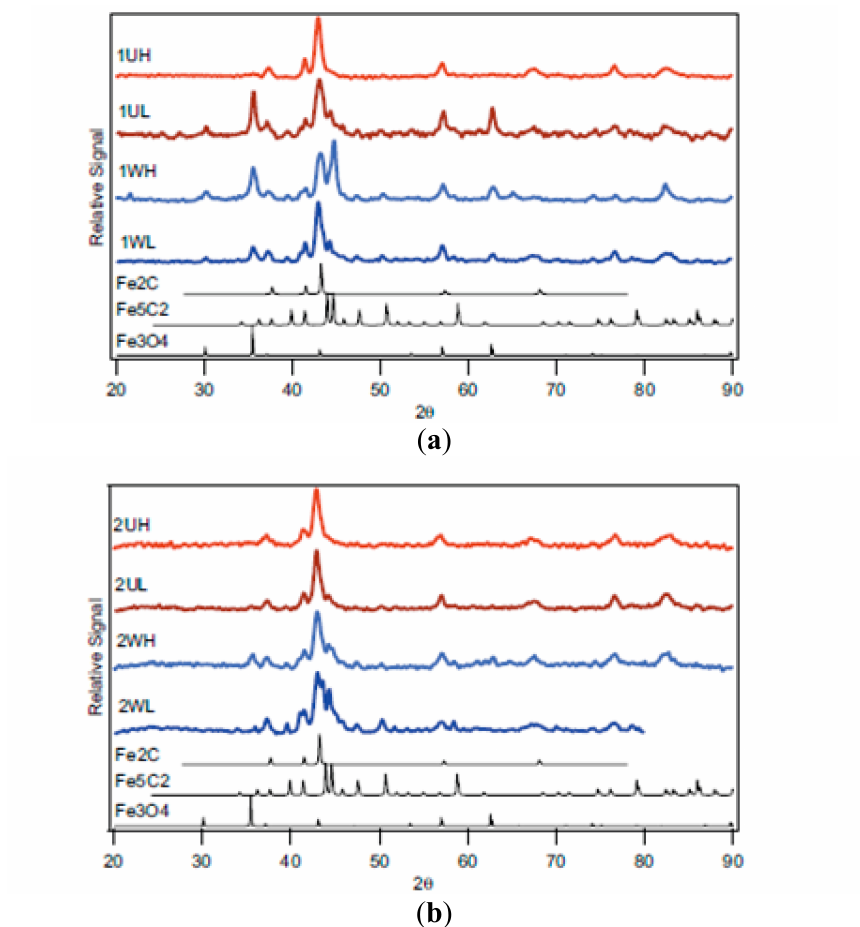
Figure 7. XRD spectra of ( a ) 1S catalysts and ( b ) 2S catalysts after FTS